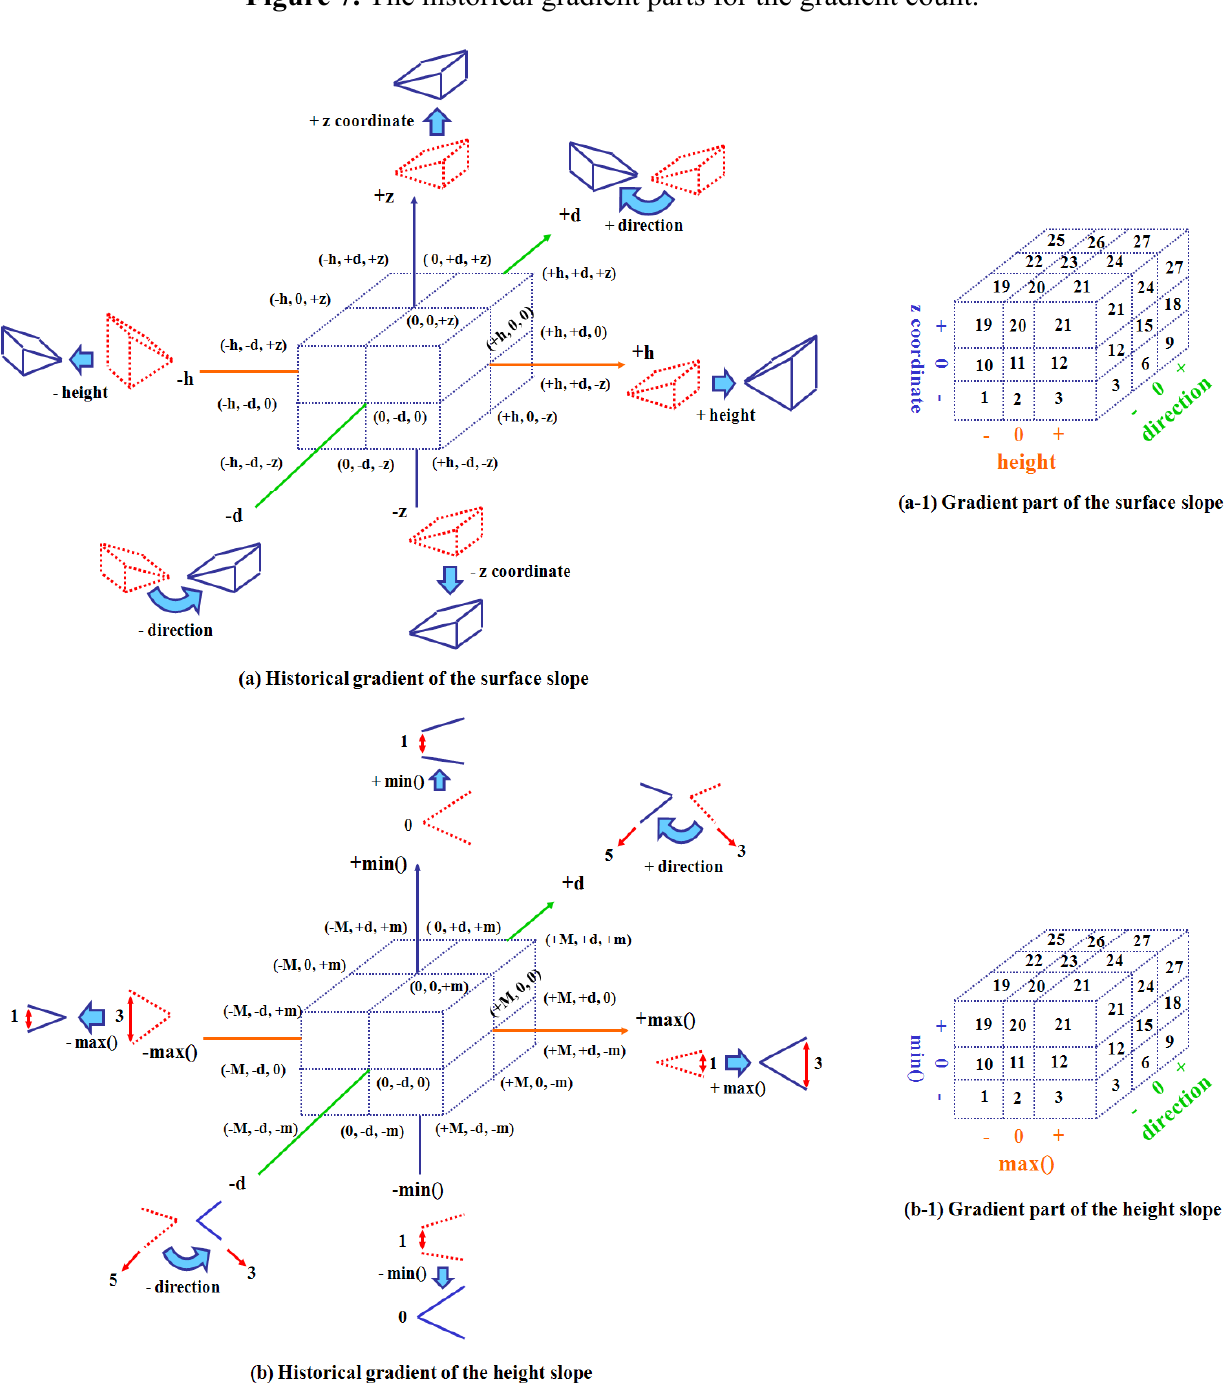
Figure 7. The historical gradient parts for the gradient